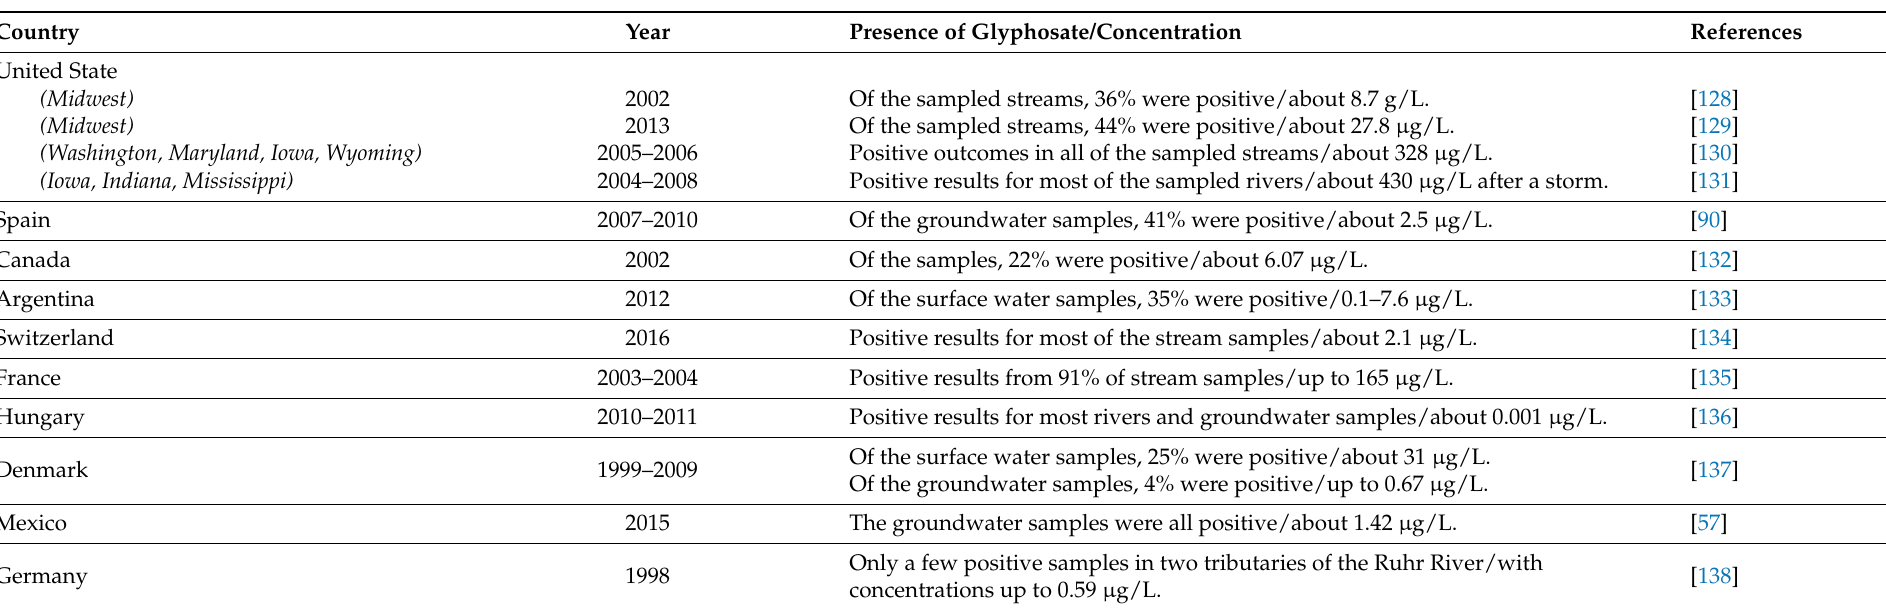
Table 2. Investigation of the presence and levels of glyphosate in surface and ground water samples collected from several countries in Europe, South America, and North